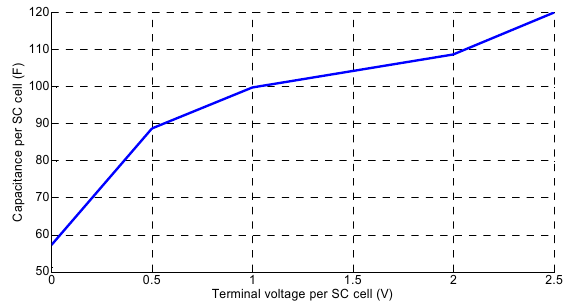
Figure 4. Supercapacitor (SC) nonlinear capacitance function [7].